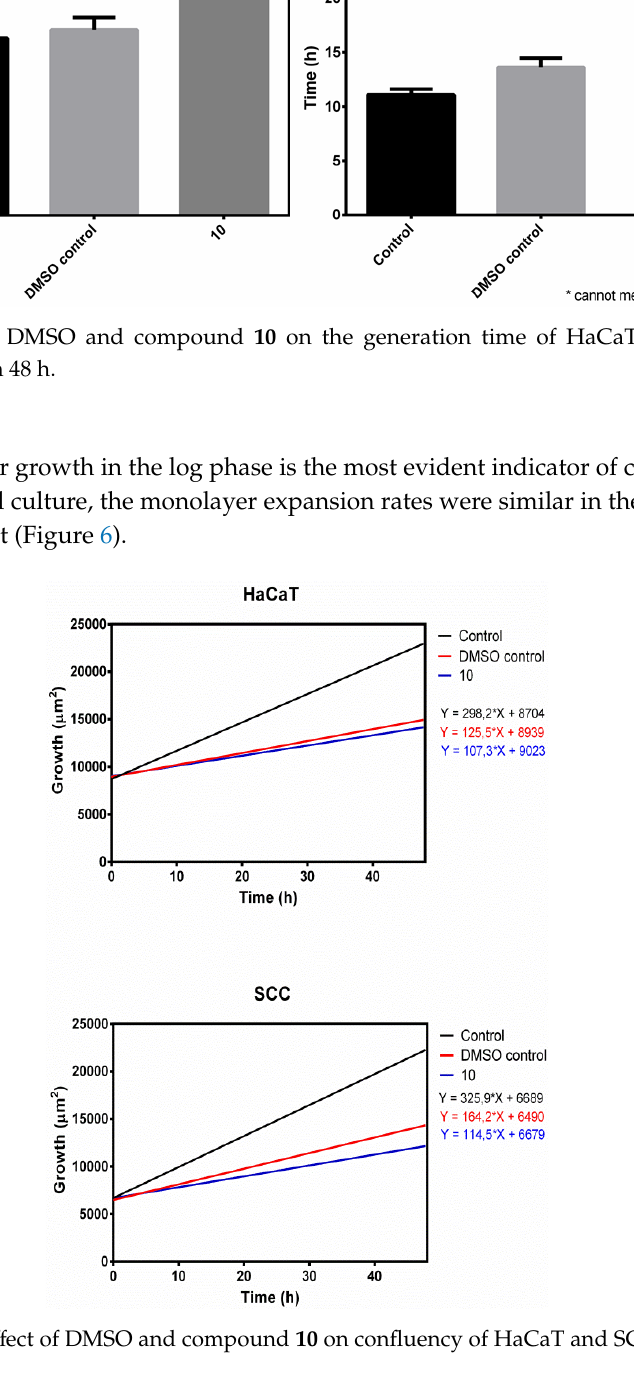
Figure 5. Effect of DMSO and compound 10 on the generation time of HaCaT and SCC cells. *: No division within 48 h.